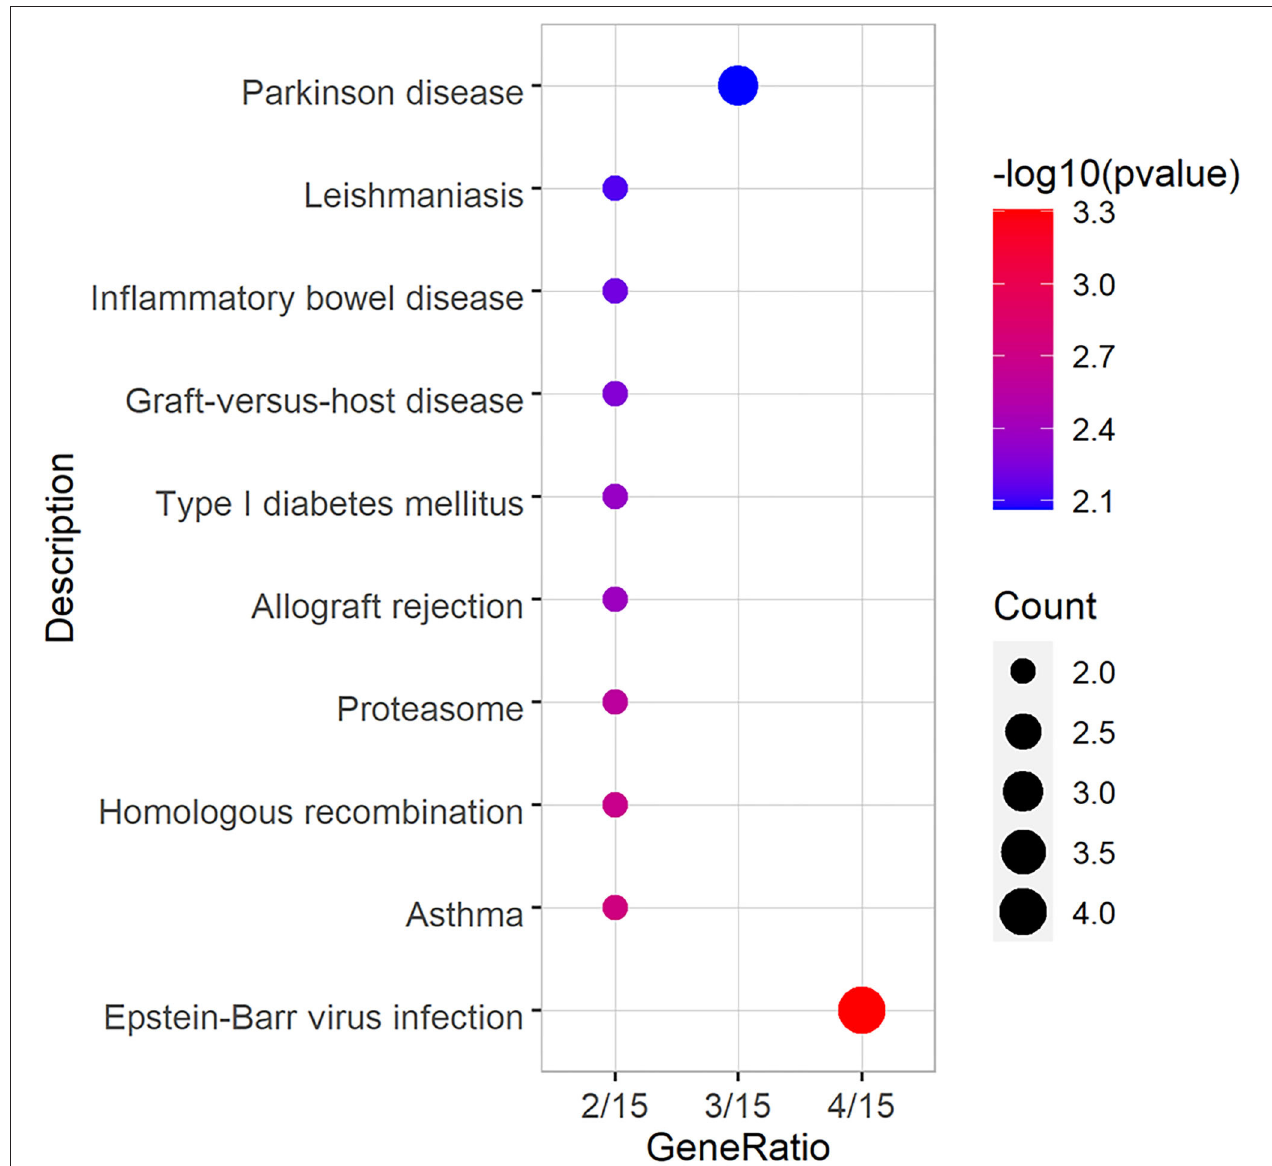
FIGURE 7 | KEGG annotation of DEGs, and the significance level of enrichment was set at P < 0.05